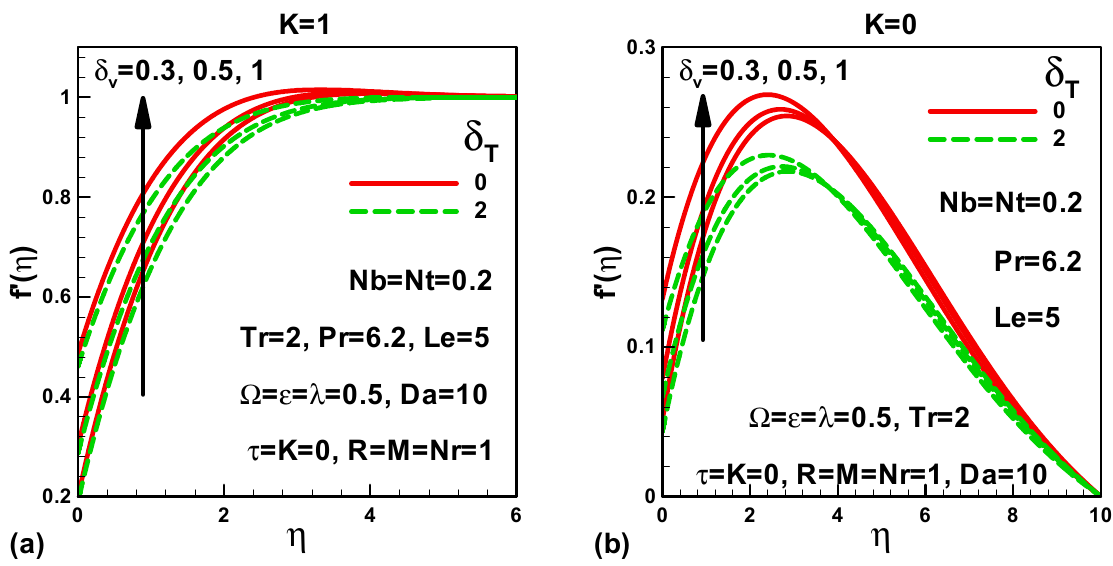
Figure 3. Effects of slip parameters on dimensionless velocity ( a ) with pressure gradient and ( b ) without pressure gradient.